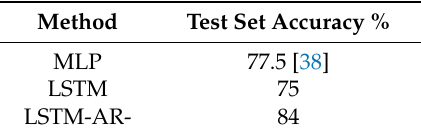
Table 4. Cross validation of